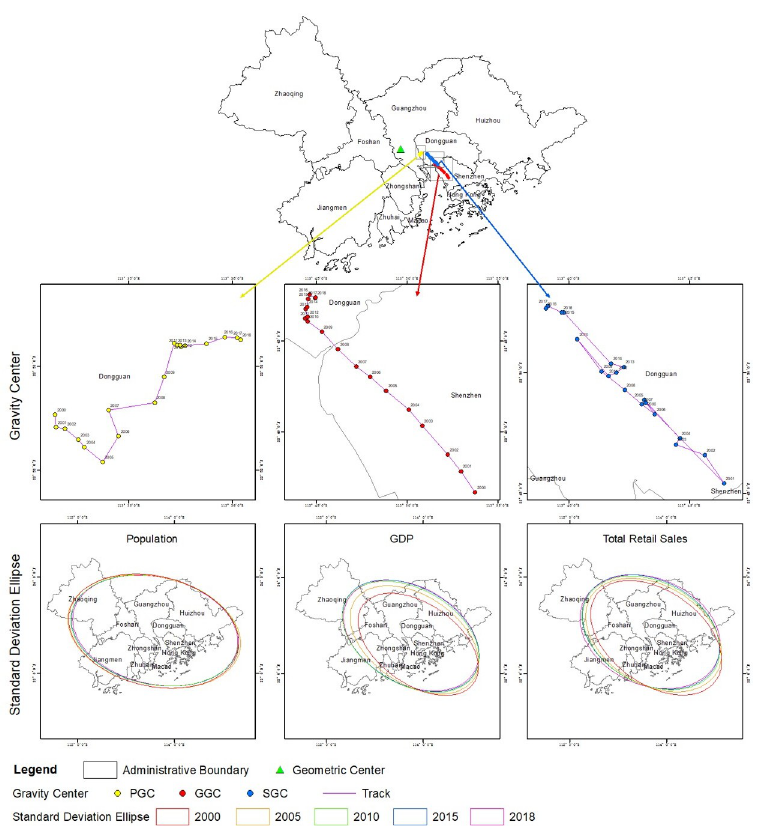
Fig 7. Gravity centers and SDEs of the population, GDP and total retail sales of the GBA. Reprinted background map from the National Catalogue Service for Geographic Information (www.webmap.cn) under a CC BY license, with permission from the National Geomatics Center of China, original copyright